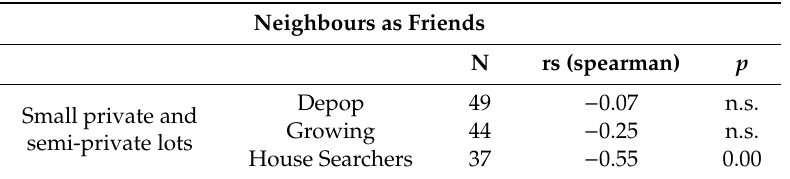
Table 5. Significance and correlation coe ffi cients rs between the levels “small private and semi-private lots” and “neighbours as friends”, according to the subgroups: “depopulating neighbourhoods”, “growing neighbourhoods”, and “house